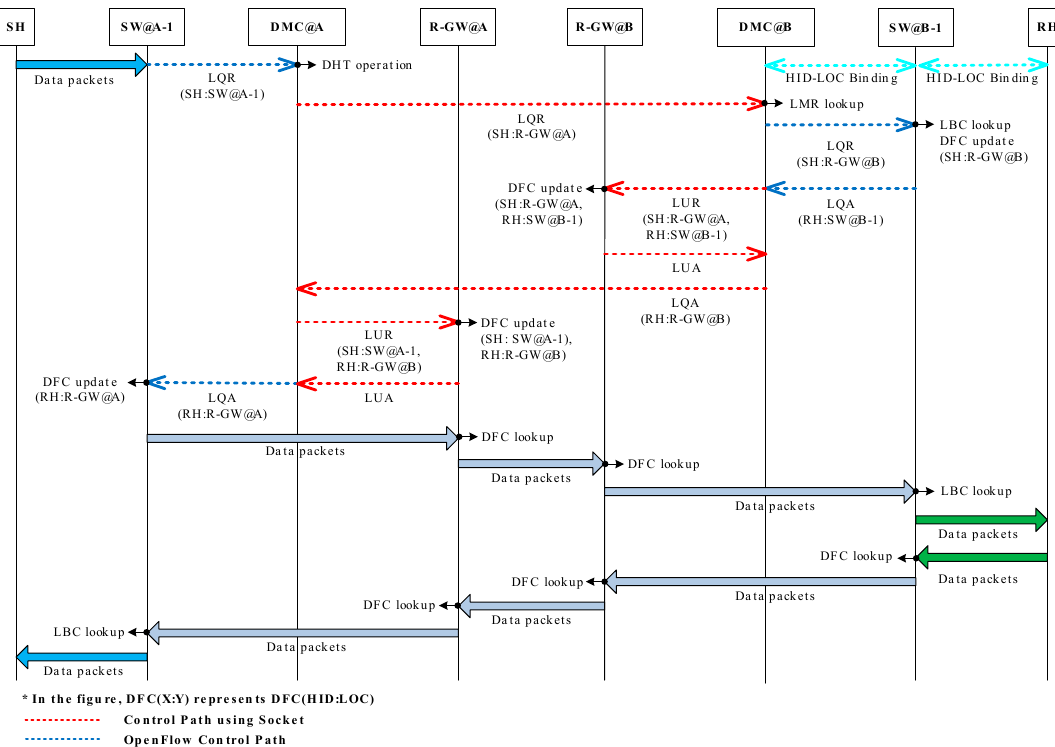
Figure 6. Inter-domain LOC query operations for data delivery (case Figure 6. Inter ‐ domain LOC query operations for data delivery (case 1).